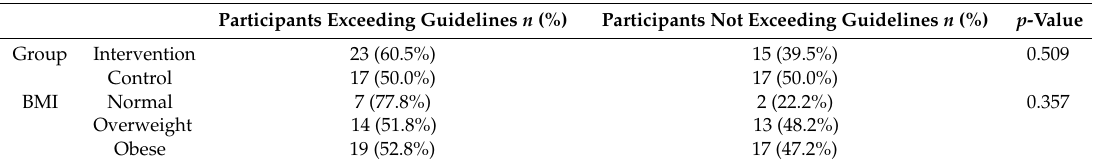
Table 3. Participants exceeding or not exceeding Institute of Medicine (IOM) GWG guidelines by treatment group and BMI category ( n =